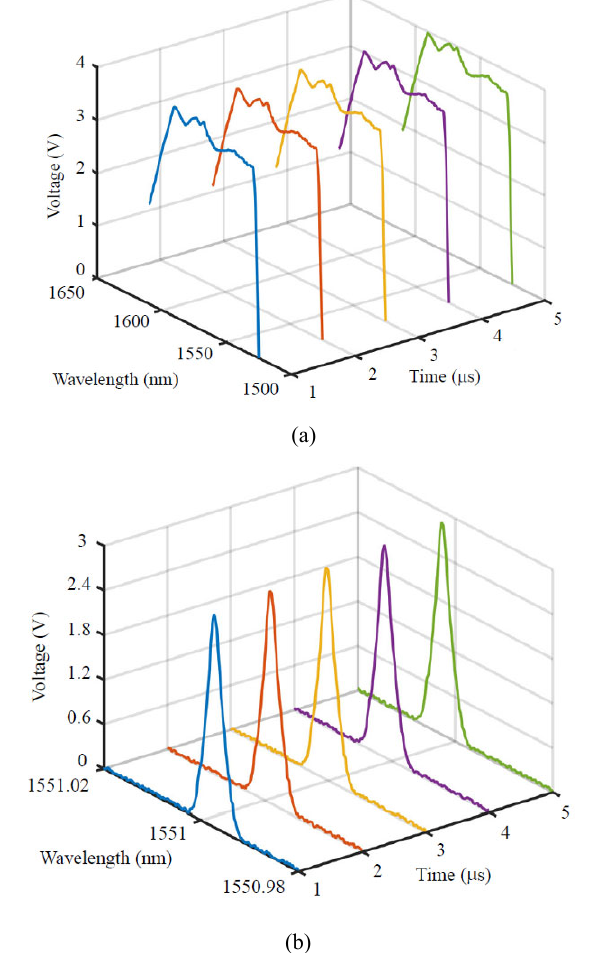
Fig. 2 Spectrum of broadband light source and F-P filter: (a) the spectrum of broadband light source and (b) the transmission spectrum of F-P